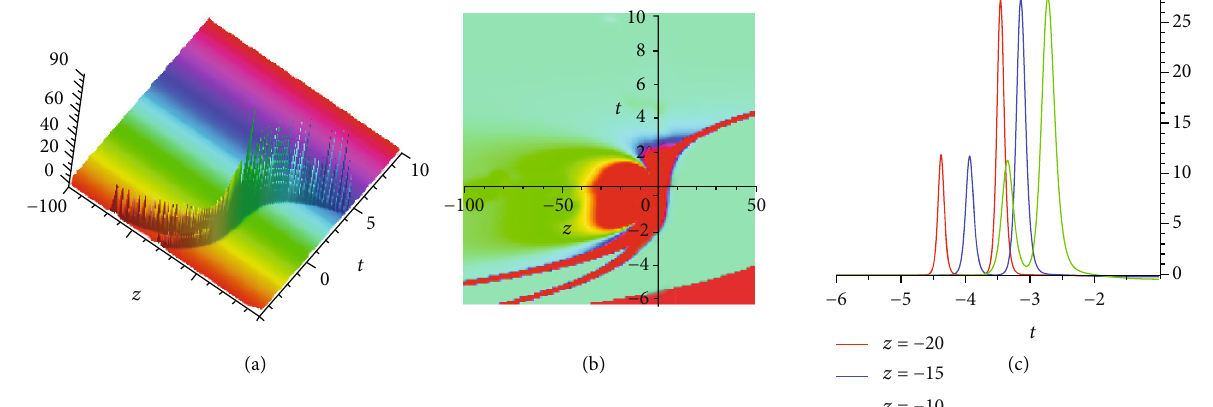
Figure 23: Plots of lump-three kink solutions (84).